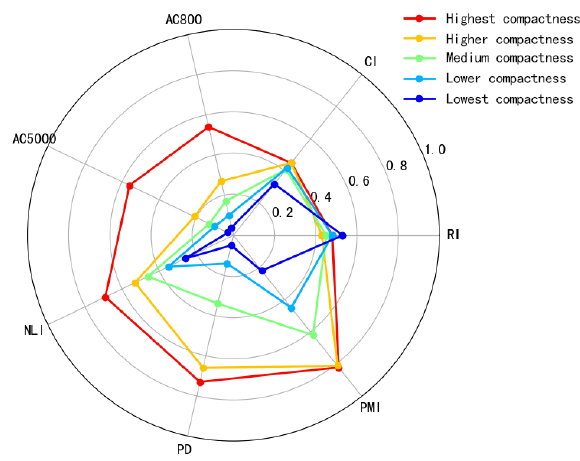
Figure 12. Radar plot of Table